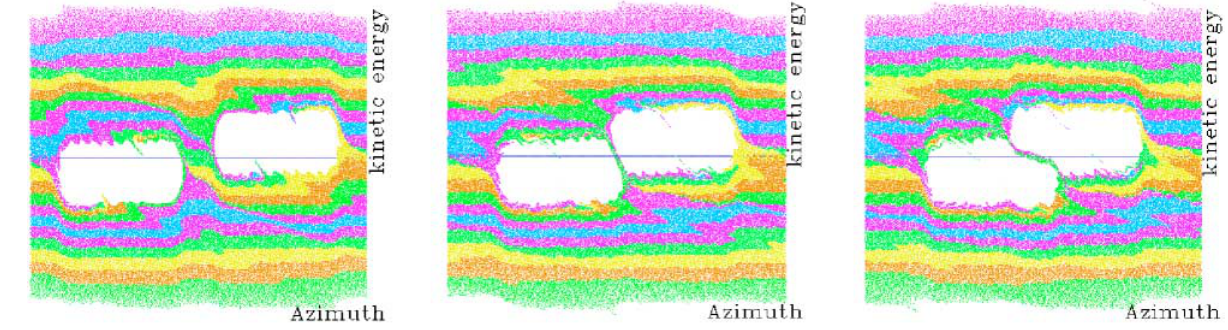
FIG. 26. (Color) Phase space scatter plots (left to right) at 2 14.62 , 2 14.37 , and 2 14.24 ms, respectively. 5 3 10 12 protons, 2.2 3 10 5 macroparticles.